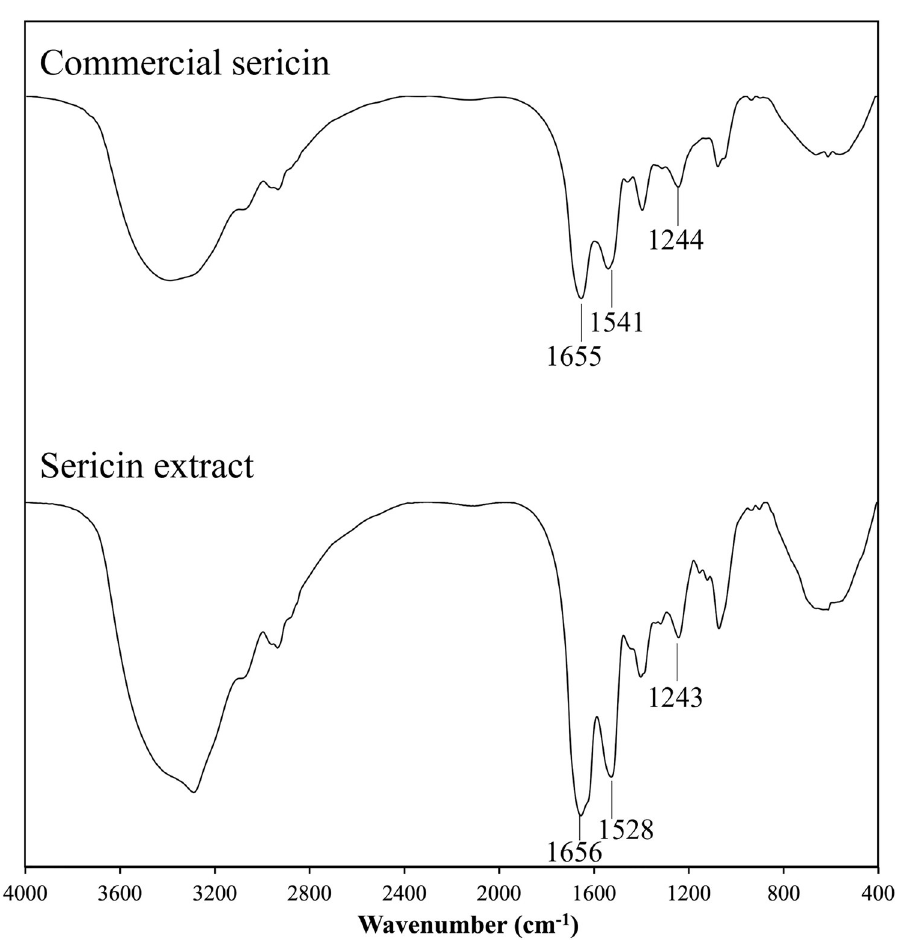
Fig 2. FT-IR spectra of in-house sericin extract and commercial sericin.